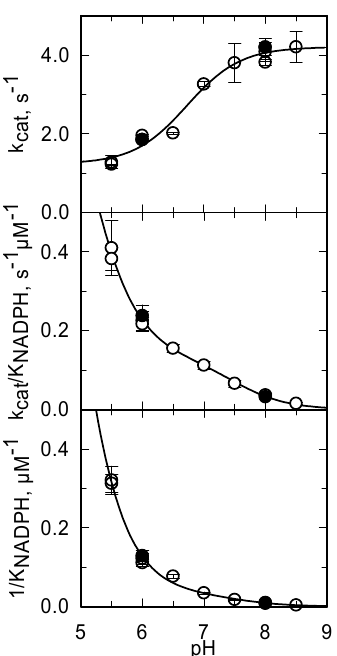
Figure 11. pH dependence of the kinetic parameters of the NADPH oxidase reaction of MICAL-MO . The steady-state kinetic parameters k measured as described in Table 3, where the values of the calculated parameters are shown. Reprinted from [70] with permission from Elsevier.